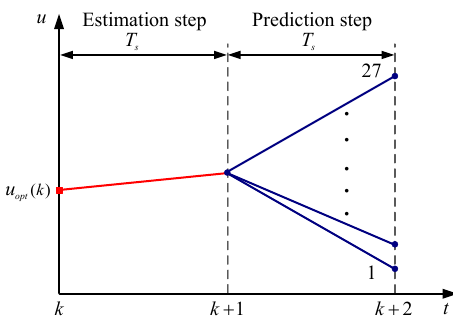
Figure 3. Control variable of one-step horizon with delay